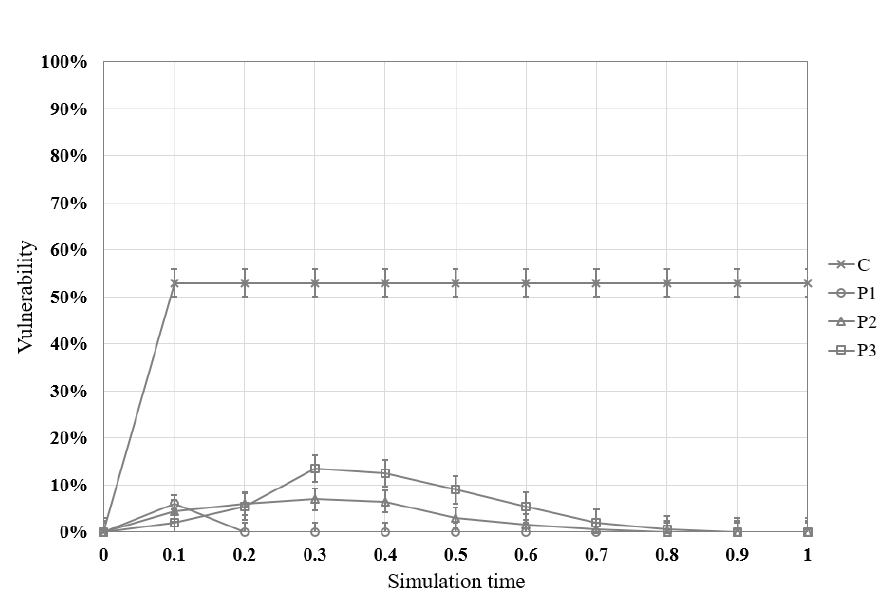
Figure 7. Comparison results of security.